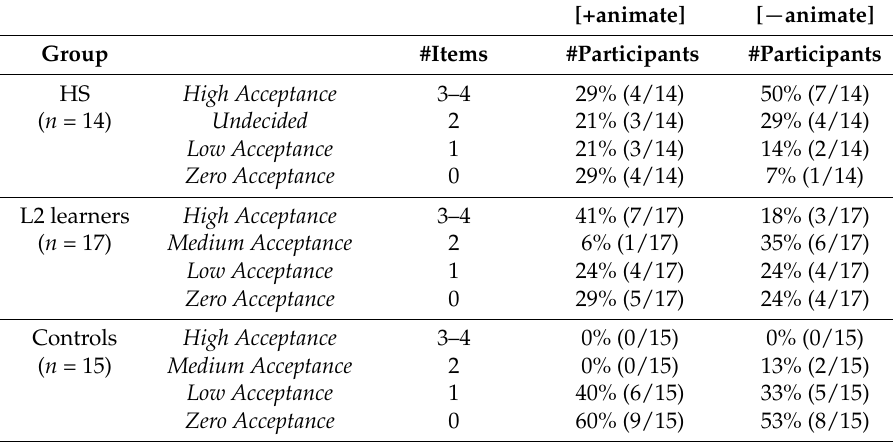
Table 6. AJT: proportion of acceptance of ungrammatical items in CLLD sentences. [+animate] [ − animate] #Items #Participants